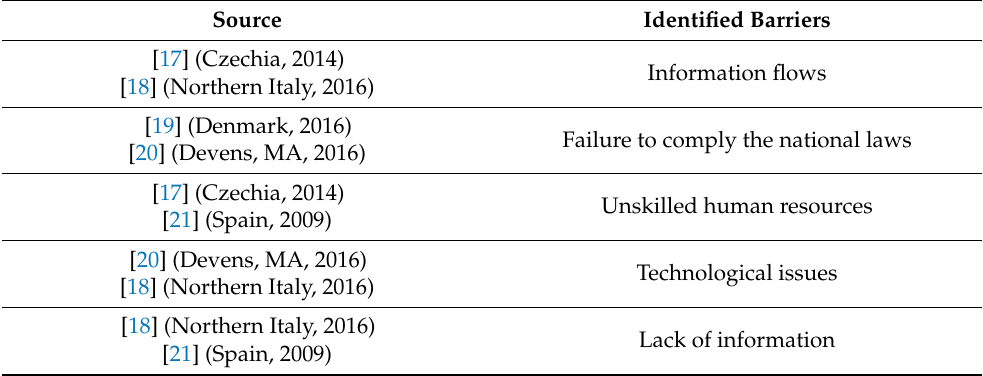
Table 1. Barriers to biomass energy